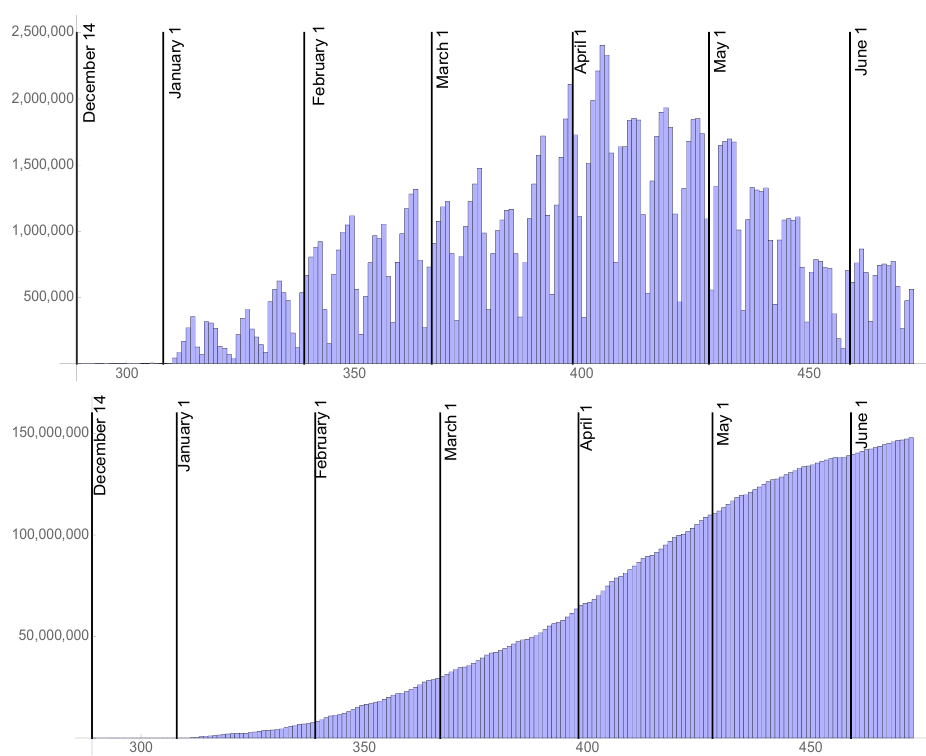
Figure 4. Daily vaccination data v daily ( t ) ( top ) and cumulative version CV ( t ) of this data ( bottom )